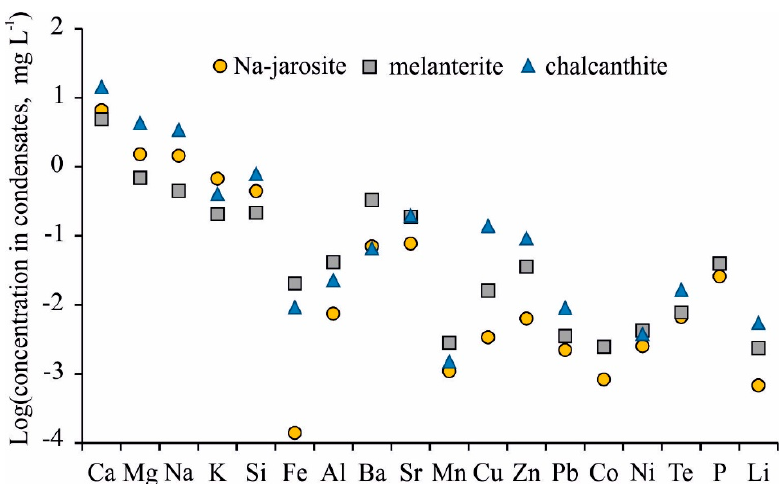
Figure 4. Mean element concentrations in gas condensates from Na-jarosite, melanterite, and chalcanthite.